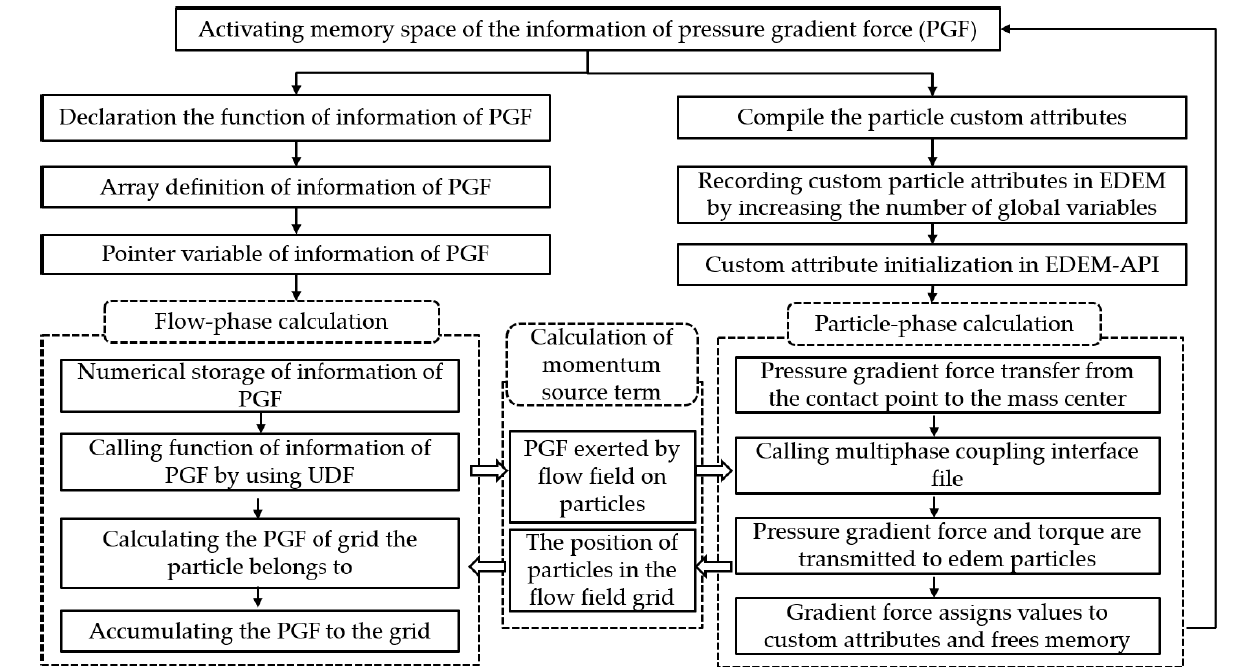
Figure 7. Diagram of compiling and transferring the pressure gradient force (PGF) during the EDEM-CFD simulation.